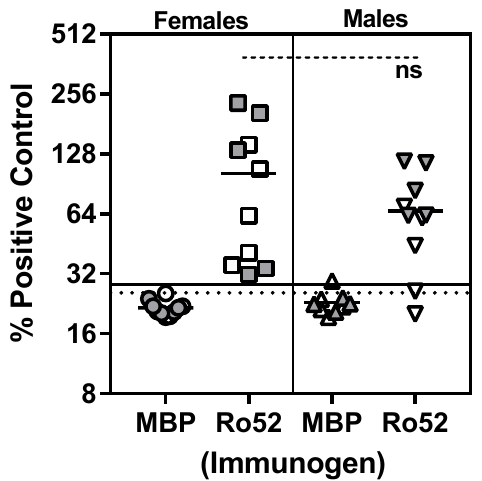
Figure 2. Analysis of anti-Ro52 antibody response in Ro52- and MBP-immunized mice. Sera obtained at 4 weeks (open symbols) and 10 weeks (filled symbols) post-immunization were analyzed for anti-Ro52 antibody levels by immunoprecipitating in vitro transcribed, translated and 35 S-labeled Ro52. Data are presented as % of a positive control anti-Ro52 serum sample. The dotted line and the solid line show reactivity cut-offs for female and male mice respectively, and they were calculated as mean % positive control for MBP + 2 S.D.